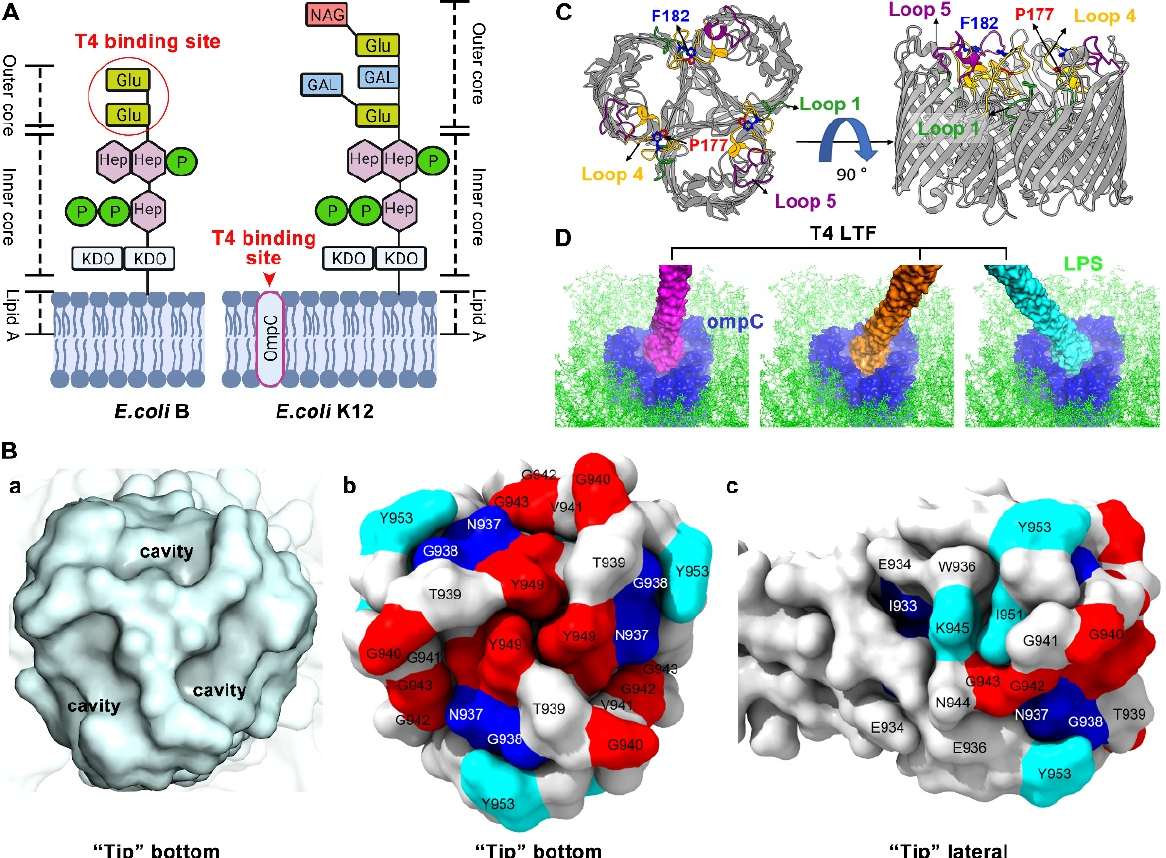
Figure 2. Molecular and structural insight of T4 long tail fiber interaction with host receptors LPS and OmpC. ( A ) Structural schematics of T4 LPS receptors on the surface of E. coli B and K12 strains: Glu, Glucose; Hep, L-glycero-D-manno heptose; P, Phosphate; KDO, 3-deoxy-D-manno-oct-2- ulosonic acid; GAL, Galactose; and NAG, N- acetylglucosamin. Created by BioRender.com. ( B ) The “tip” surface structures and the critical amino acid residues involved in host receptor binding [58]. (a) The bottom surface structure of the “tip” showing three small cavities, each suitable for the accommodation of one glucose moiety. (b) The key residues on the bottom surface of the “tip”. (c) The key residues on the lateral surface of the “tip”. ( C ) OmpC viewed from the top (left) and the side (right) [75]. The T4 phage LTF binding components, loops 1, 4, and 5, and residues P177 and F182, are highlighted. The outer and inner membranes of E. coli K12 are indicated by the gray bars. ( D ) The T4 LTF “tip”-OmpC docking model at different angles [58]. Illustrations 2C and 2D were re- made by UCSF ChimeraX [81].